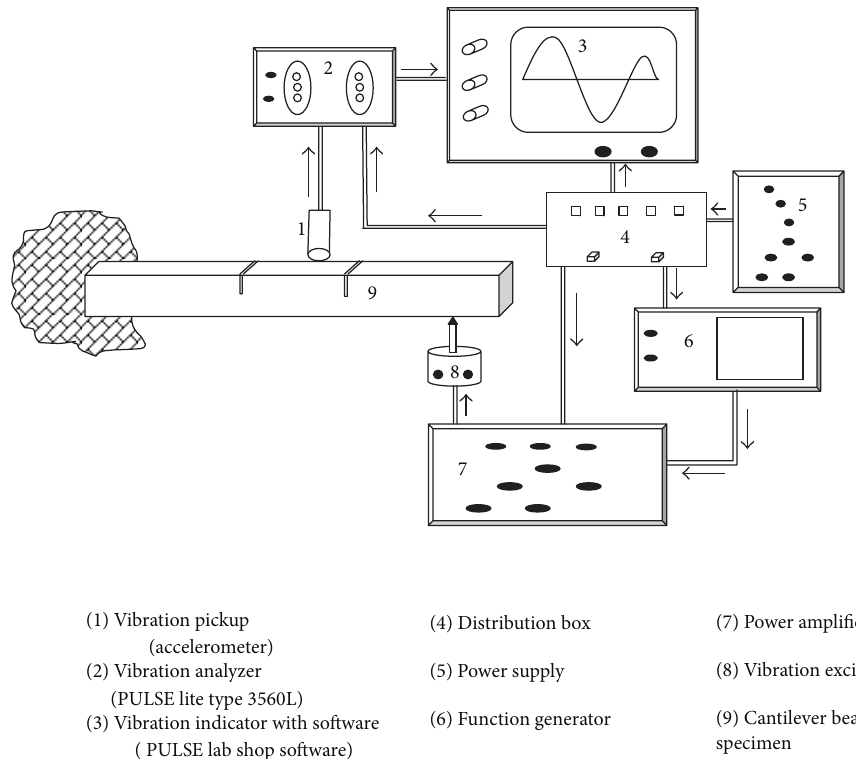
Figure 9: Schematic block diagram of experimental